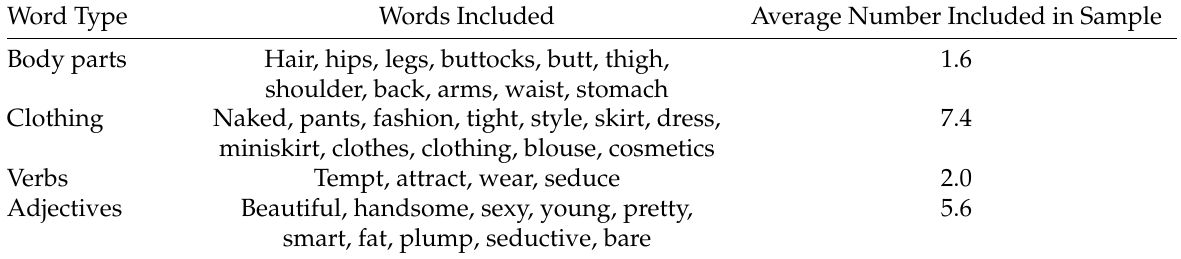
Table 1: Words included in the attractiveness dictionary. Word